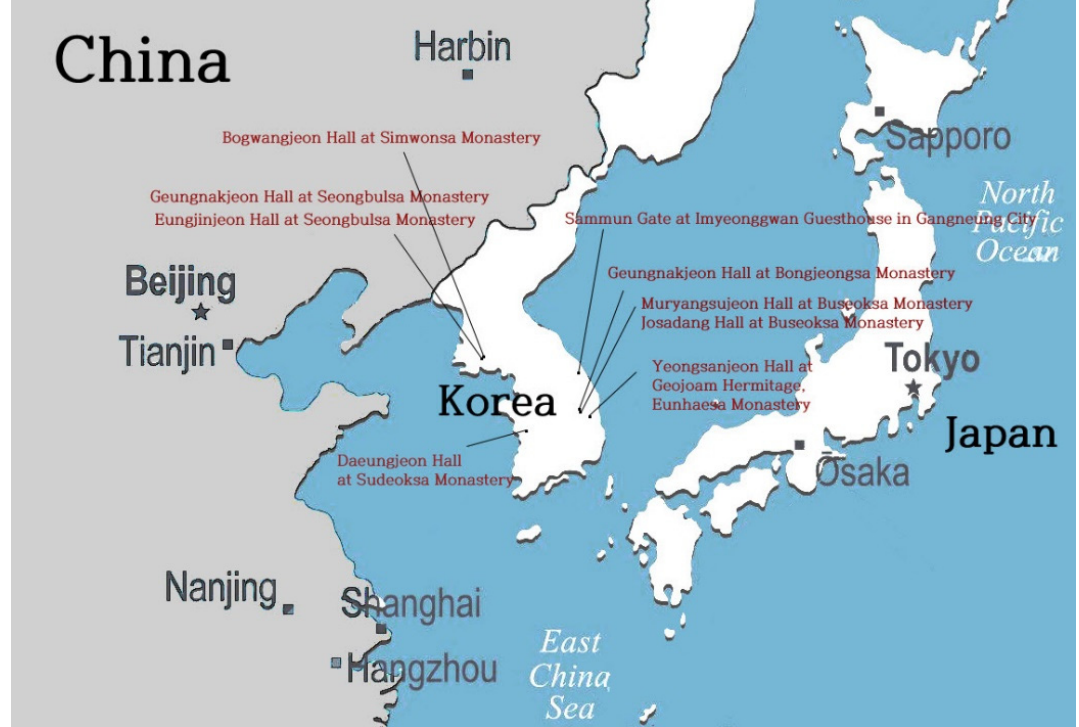
Figure 1. A Map depicting the location of the target buildings in the Korean Peninsula.